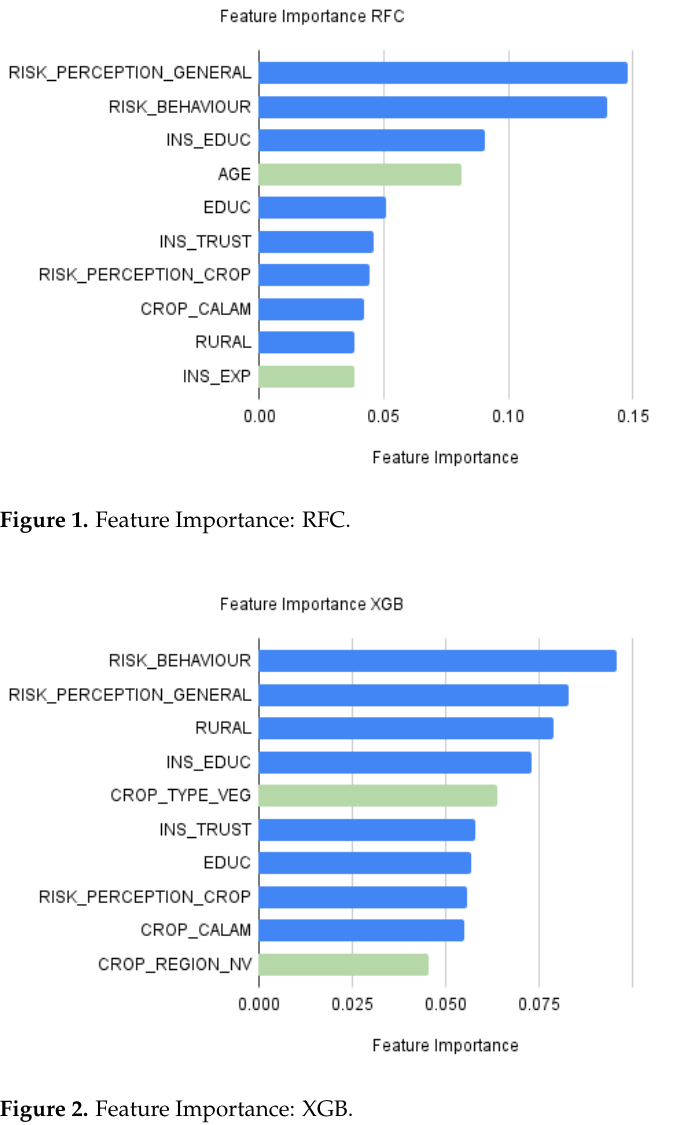
Figure 2. Feature Importance: